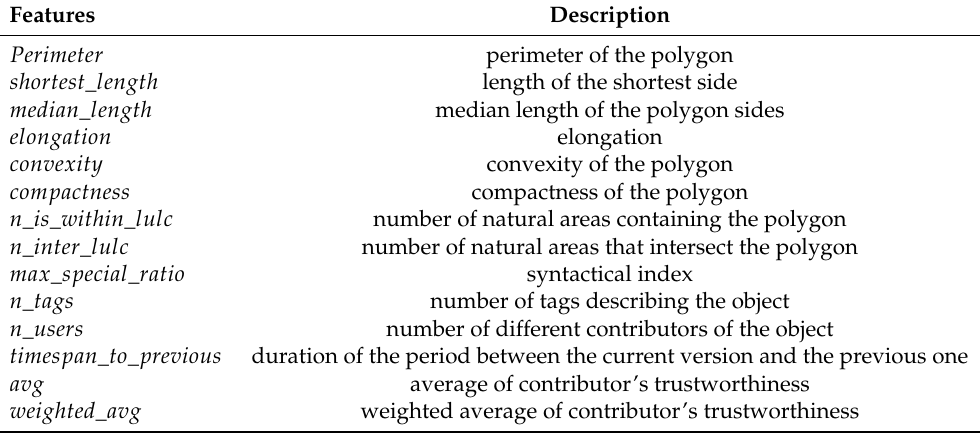
Table 3. Selected